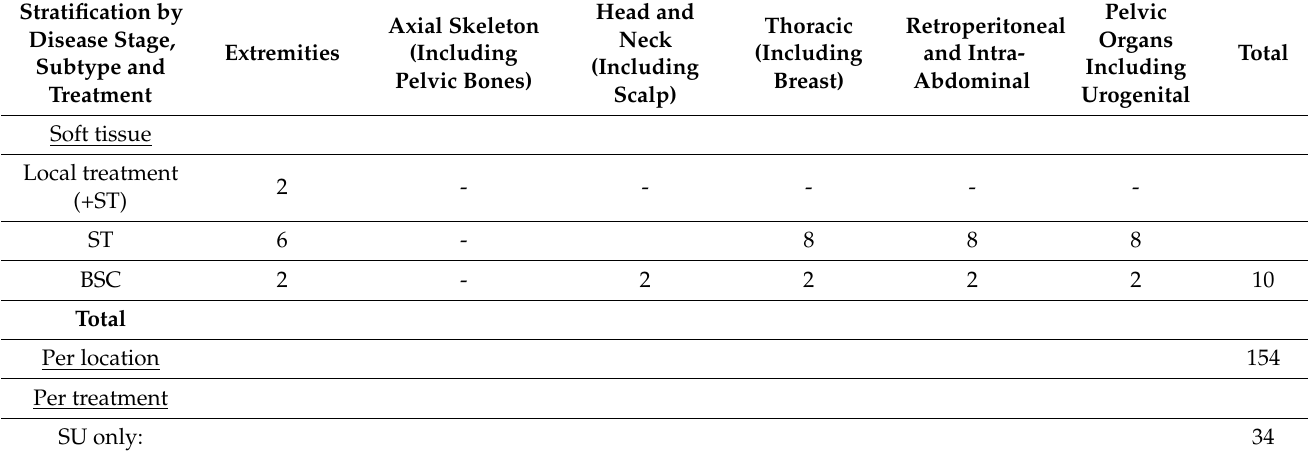
Table 1. Cont. Stratification